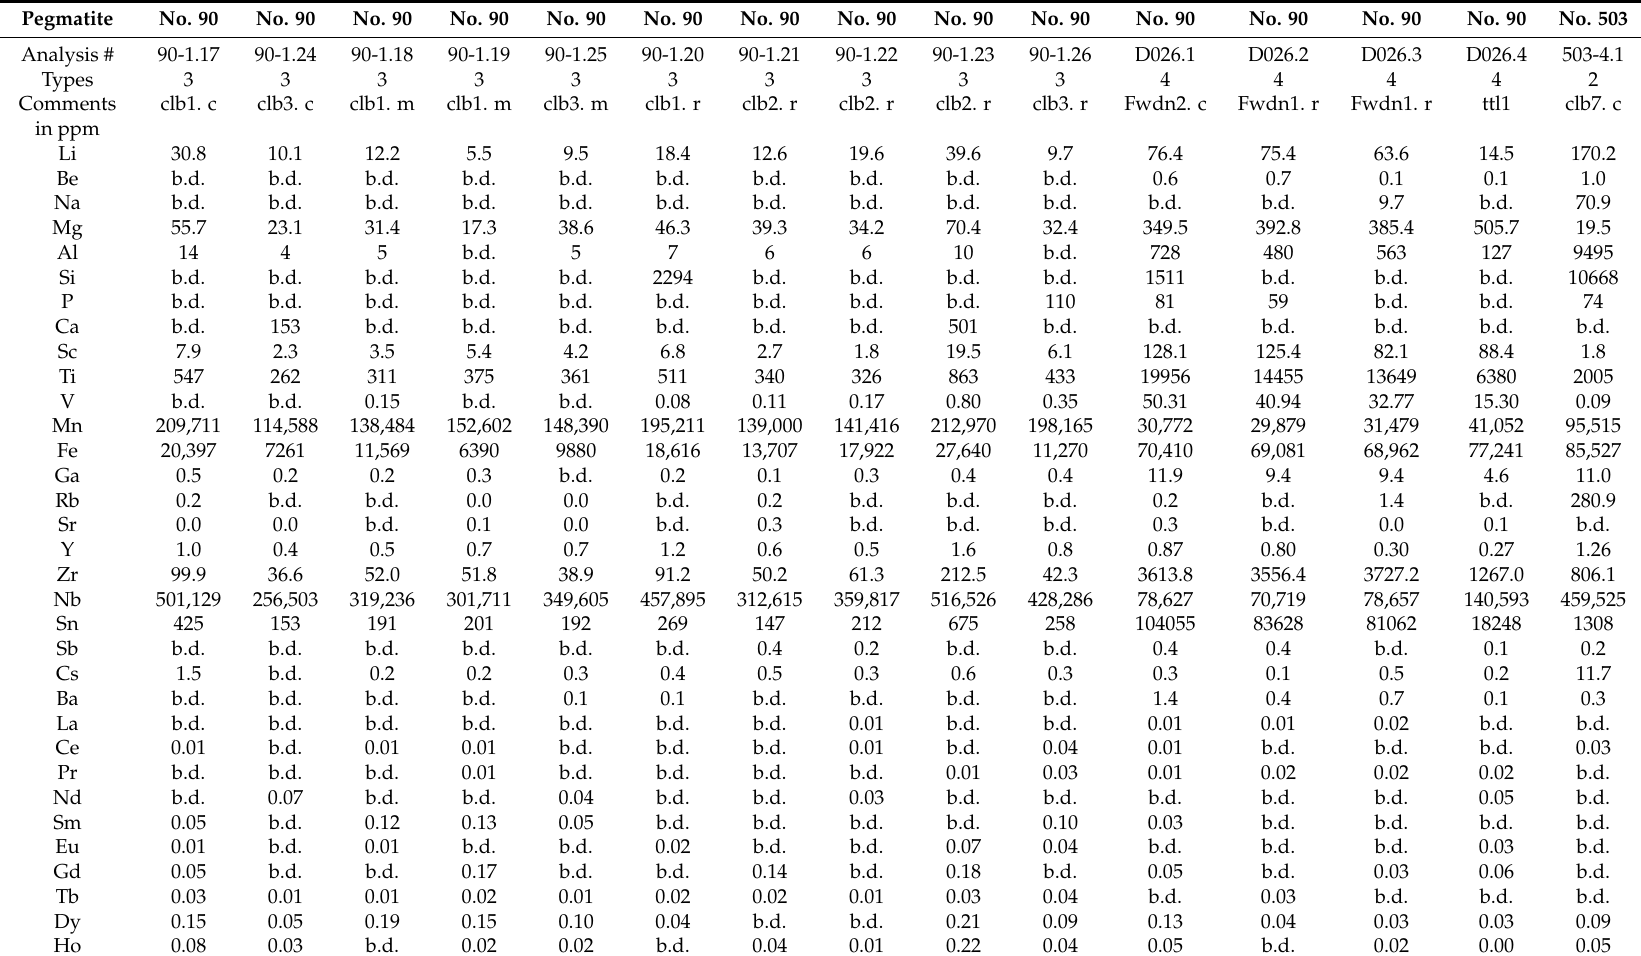
Table 4. LA-ICP-MS analyses of CGM from the Dahongliutan albite-spodumene